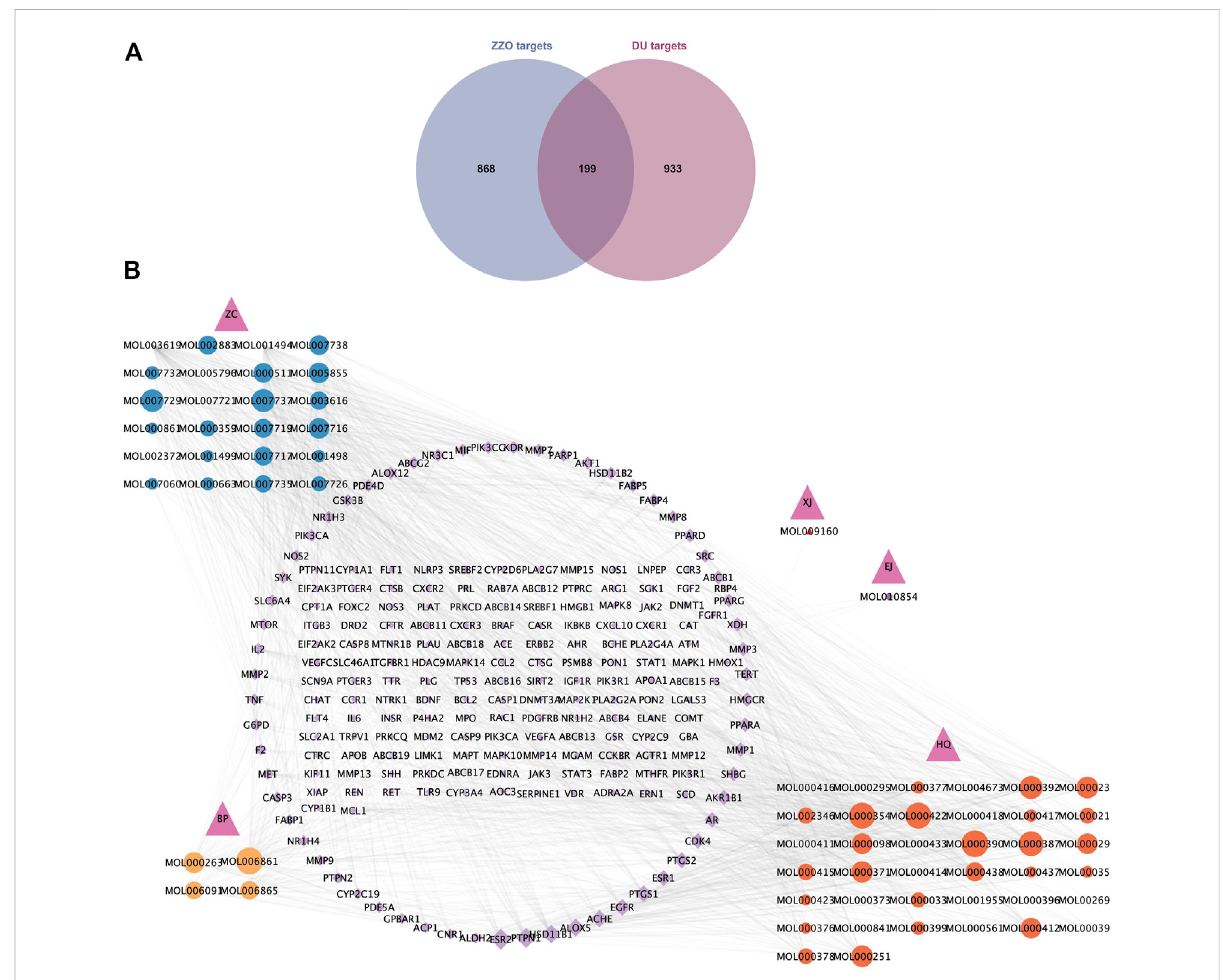
FIGURE 3 CommontargetsandC-Tnetworkofanti-DUZZO. (A) TargetscommontoZZOandDU.Thereare199commontargetsbetweenZZOandDU. (B) C-T network of ZZO anti-DU. Pink triangles represent herbal medicines, circles represent compounds, and diamonds represent targets. Node size re fl ects node degree: bigger size means a larger degree